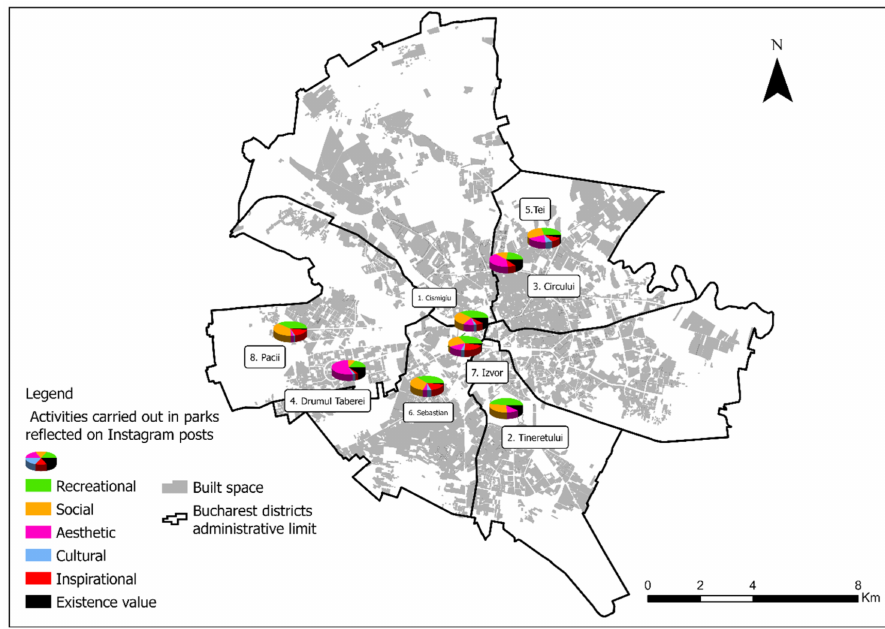
Figure 4. The main activities carried out in selected parks as reflected on Instagram posts (source: own